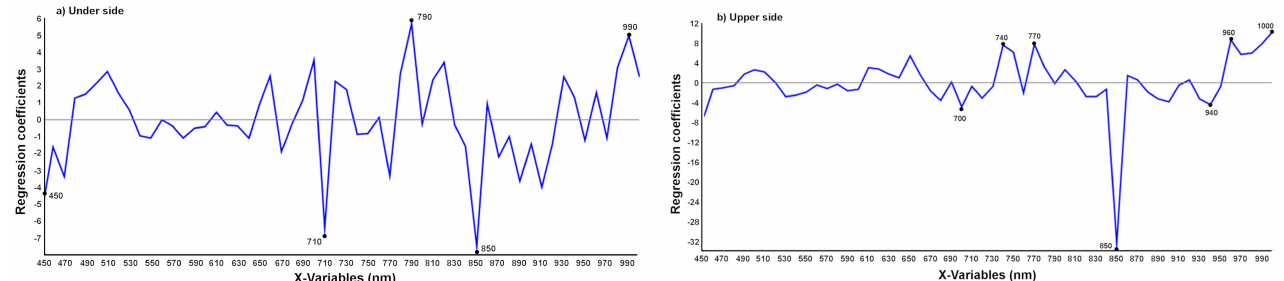
Figure 7. Vector of regression coefficients of the PLS model using mean spectra and with the optimal wavelengths selected on ( a ) under side and ( b ) upper side of the leaf.